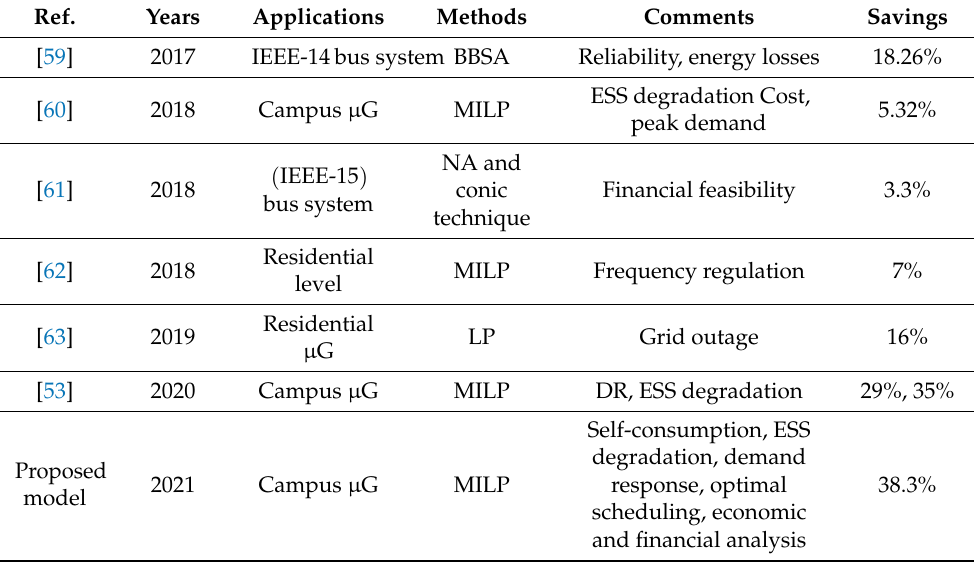
Table 9. Proposed methodology comparison with the current works.